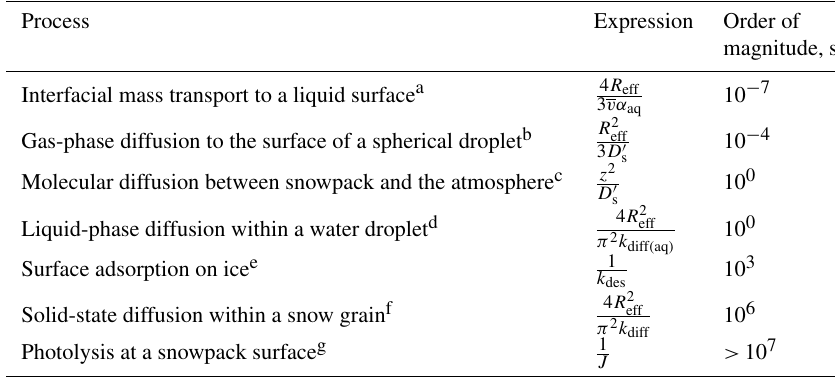
Table 1. Characteristic times associated with gas-phase diffusion, mass transport and uptake of gas into ice grain. Process Expression Order of